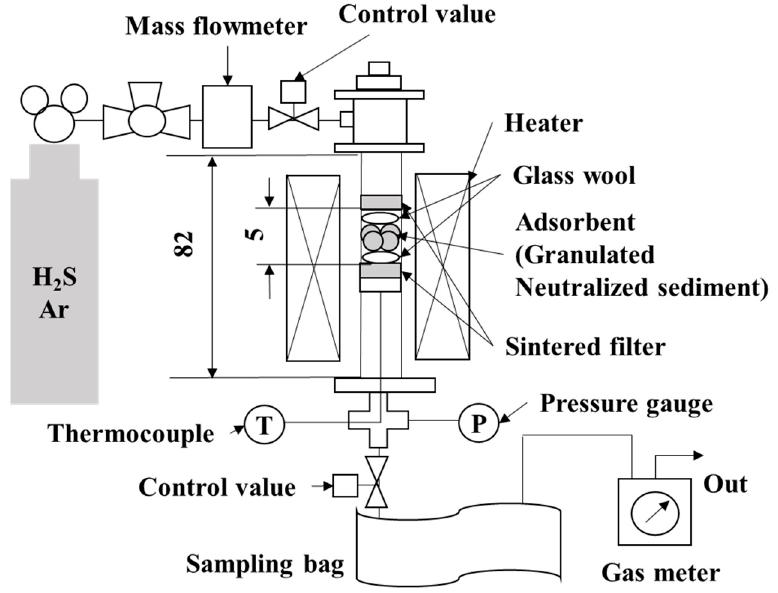
Figure 1. Schematic of dynamic H 2 S adsorption experiment.